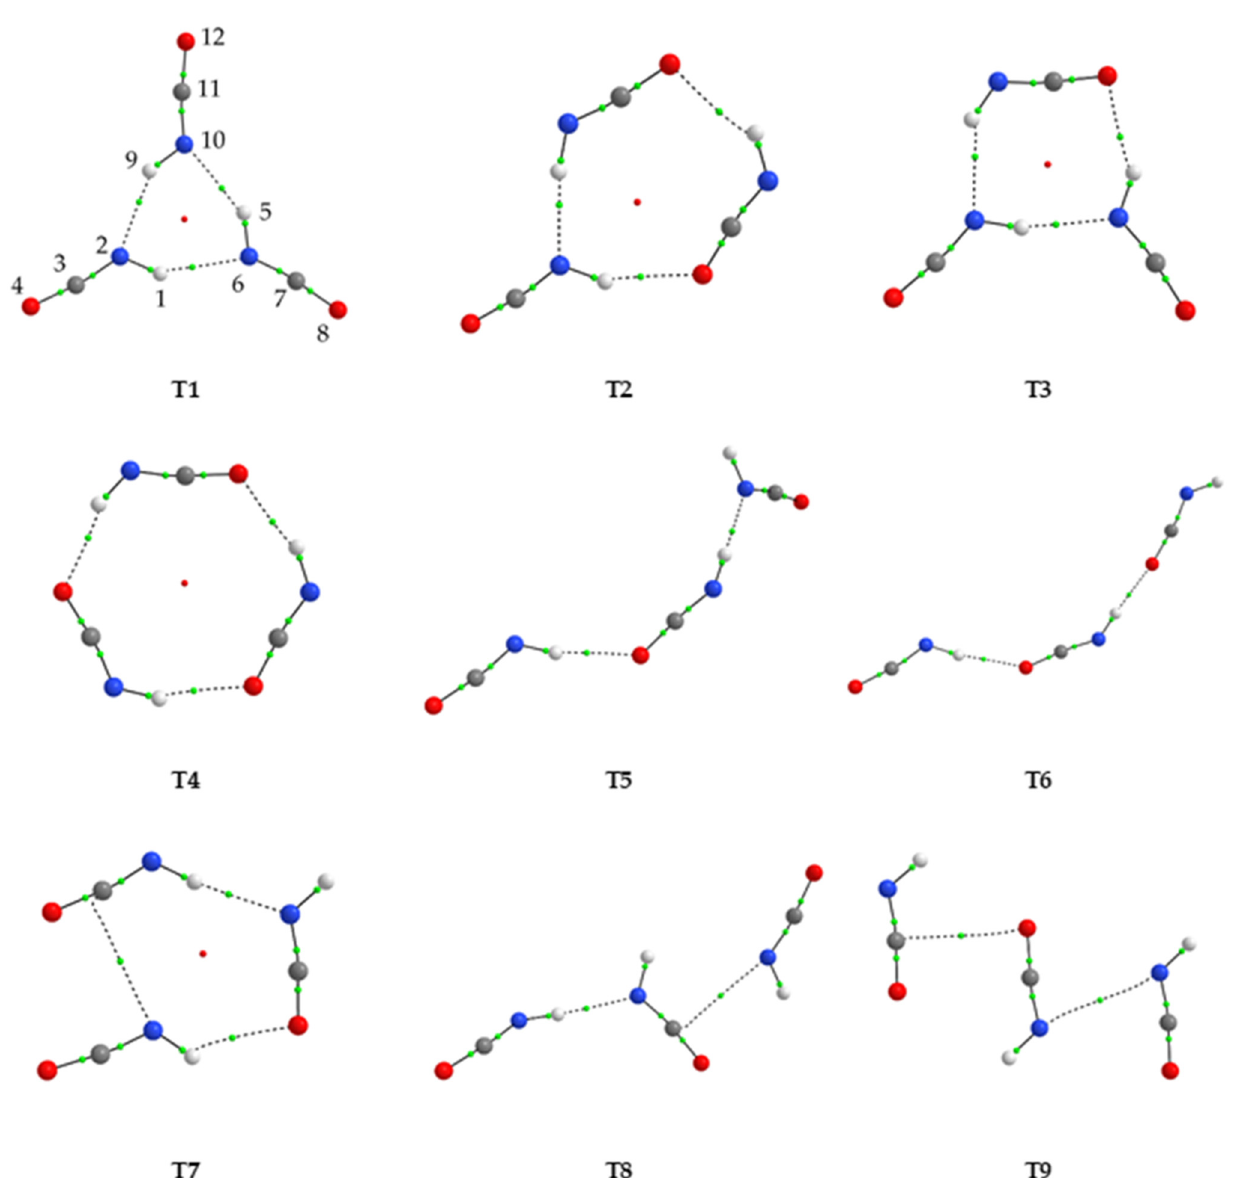
Figure 2. The MP2-optimized structures of the HNCO trimers. The H, N, C and O atoms are shown in white, blue, gray and red, respectively. The positions of the bond (3, − 1) and ring (3,+1) critical points derived from AIM calculations are shown by small green and red dots, respectively.